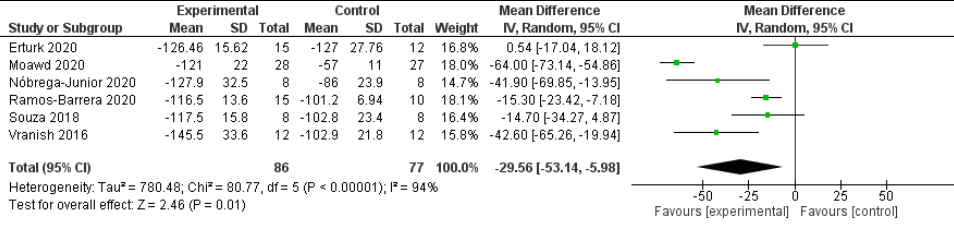
Figure 8. Forest plot for maximum inspiratory pressure.